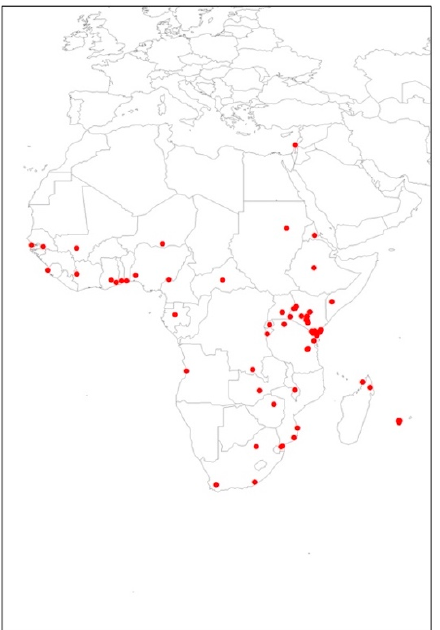
Figure 1. Occurrence points of Thaumatotibia leucotreta utilized in the study.